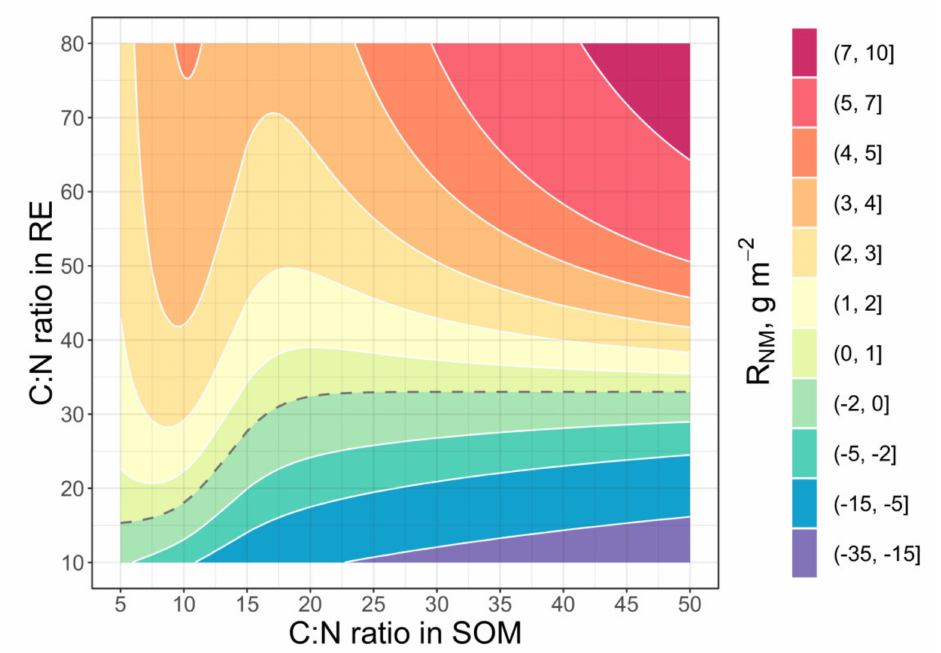
Figure 4. Simulated effect of extra C mineralisation at priming effect ( R NM in Equation (12)) from rhizosphere SOM depending on C:N ratio of exudates and C:N ratio of the rhizosphere SOM. The simulation at the rhizosphere soil scale testing was run for 20 days; exudate input is equal to 0.5 g [C] m –2 day –1 . An area with high C:N of RE and rhizosphere SOM has high PE while the area with very low C:N of RE has negative